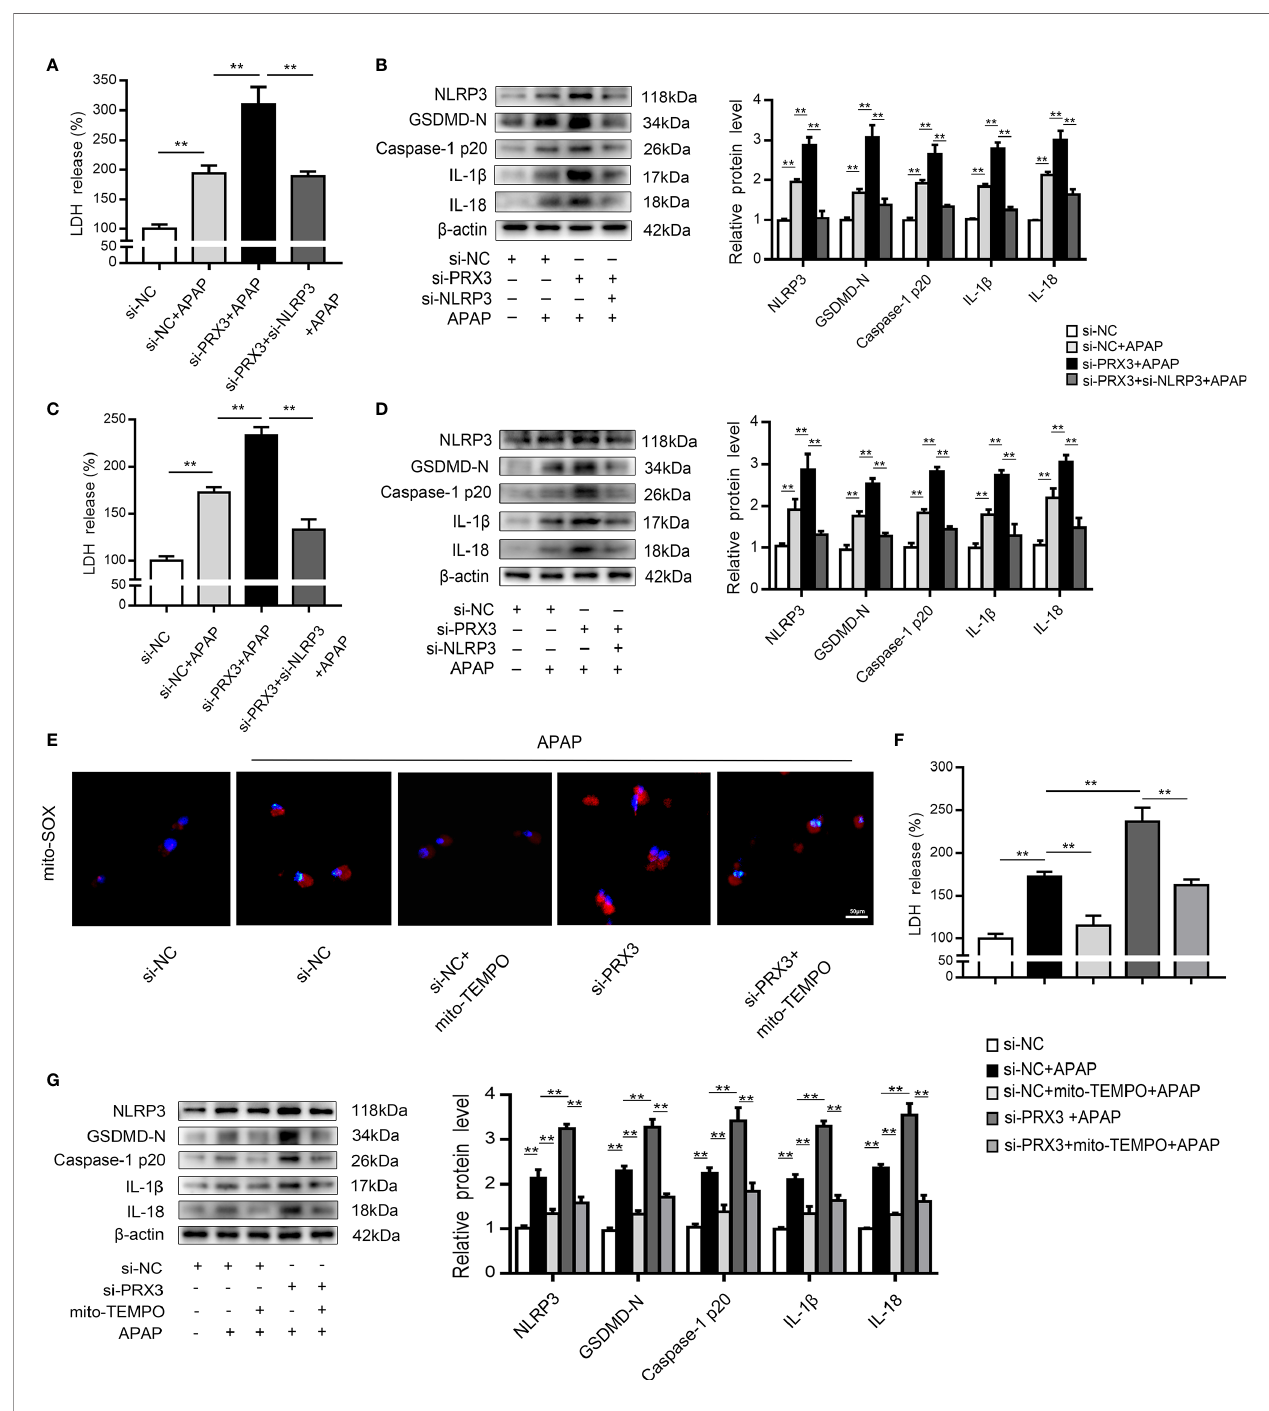
FIGURE 5 | PRX3 regulates the NLRP3 in fl ammasome through mitochondrial ROS after APAP overdose. Primary KCs and hepatocytes were cotransfected with PRX3- and NLRP3-speci fi c siRNAs following APAP challenge. (A) Kupffer cellular supernatant levels of LDH were assessed, n=6. (B) NLRP3, GSDMD-N, caspase-1 p20, IL-1 b and IL-18 protein levels in primary KCs n=3. **P<0.01. (C) Hepatocellular supernatant levels of LDH were assessed, n=6. (D) NLRP3, GSDMD-N, caspase-1 p20, IL-1 b and IL-18 protein levels in primary hepatocytes, n=3. **P<0.01. PRX3 suppression was applied in primary hepatocytes via PRX3-speci fi c siRNA transfection and subsequent Mito-TEMPO (0.2 mM) treatment before APAP intervention. (E) Representative fl uorescence images of MitoSOX, 50 m m. (F) hepatocellular supernatant levels of LDH were assessed, n=6. (G) NLRP3, GSDMD-N, caspase-1 p20, IL-1 b , and IL-18 protein levels in primary hepatocytes, n=3.